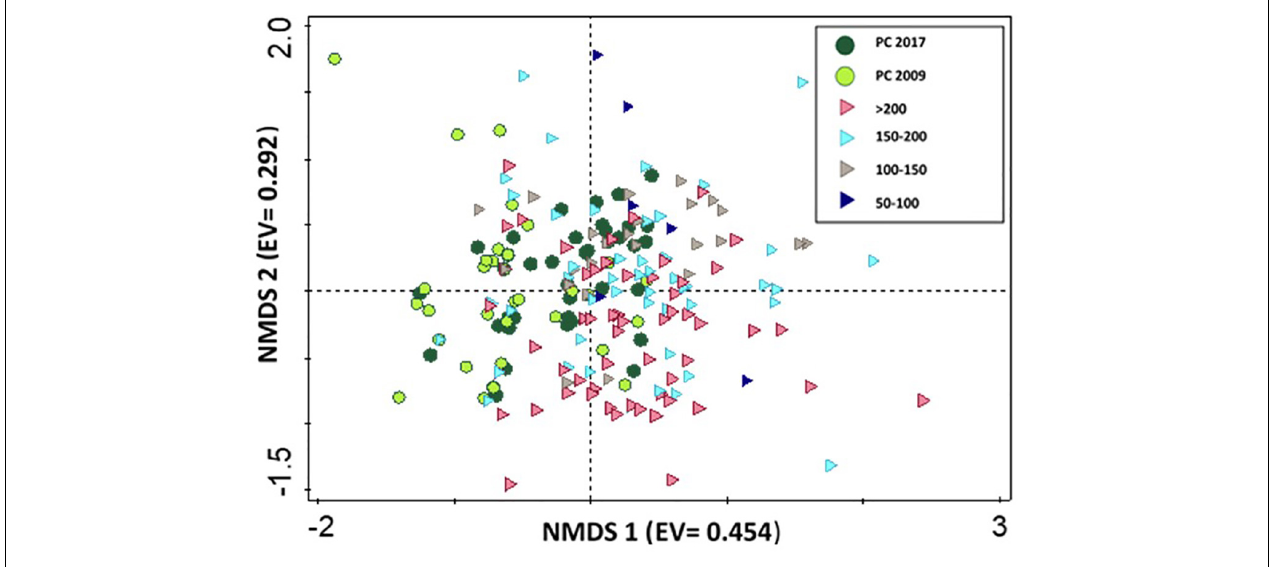
FIGURE 4 | NMDS ordination of bryophytes assemblages on coarse woody debris in years 5 (2009) ( n = 44 CWD), and 14 (2017) ( n = 50 CWD), and a chronosequence of old growth forest ( n = 145 CWD). Eigenvalues (EV) in brackets. Symbols indicate partial cut 2017 (green circle), partial cut 2009 (black circle), > 200 (purple right triangle), 150–200 (blue right triangle), 100–150 (gray right triangle) and 50–100 (blue right triangle). Stress value =